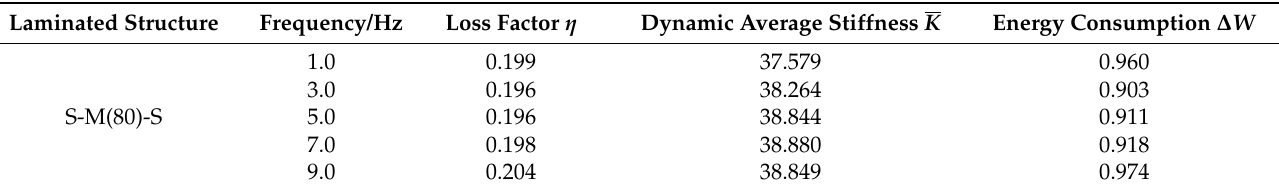
Table 9. Dynamic parameter variation with frequency.